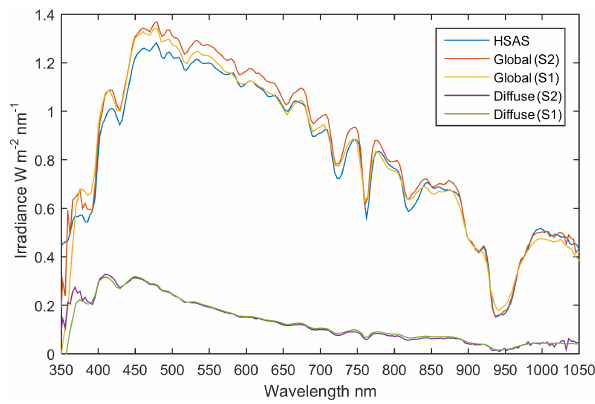
Figure 13. Spectral outputs ( I G and I D ) from the two spectrometers compared with the HyperSAS I G at 12:00 on 4 October